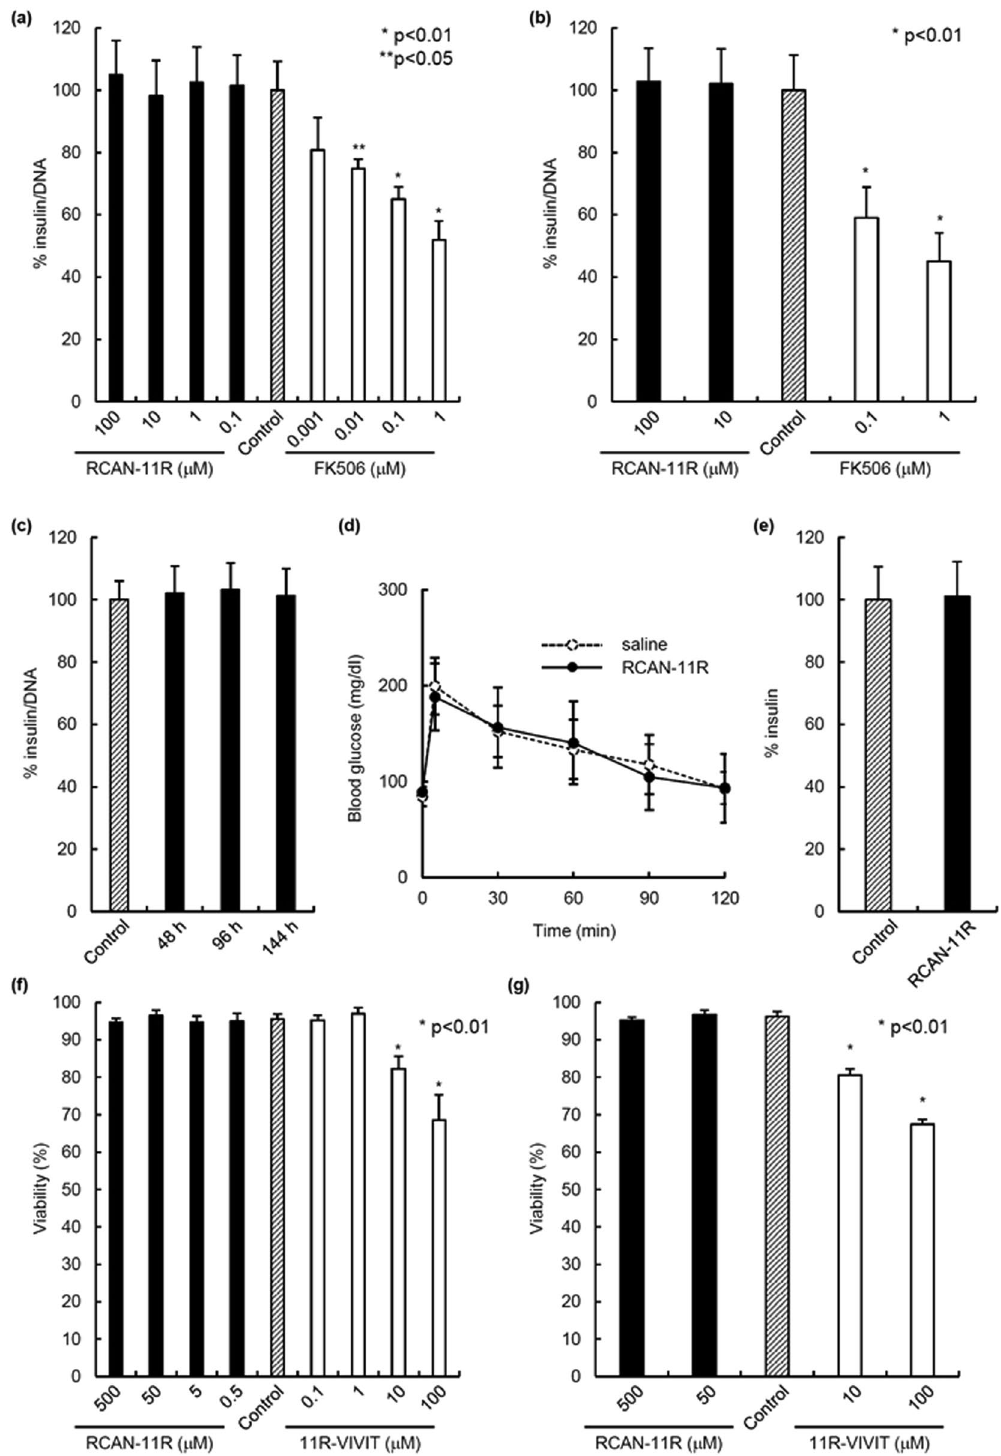
Figure 5. The effects of RCAN-11R on insulin secretion and cell viability. ( a ) Insulin secretion in β -cell line, β TC6 cells. β TC6 cells were added to 96-well plates (50,000 cells/well) with FK506 or with RCAN-11R in complete medium. The medium with FK506 or with RCAN-11R was changed every 24 hours. After 96 hours, the medium was changed and the samples for investigating the release of insulin were taken 1 hour later. The values represent the mean ± SE of five independent experiments. ( b ) Insulin secretion in isolated islets from BALB/c mice. Isolated islets from BALB/c mice were added to 24-well plates (250 IE) with FK506 or with RCAN-11R in complete medium. The medium with FK506 or with RCAN-11R was changed every 24 hours. After 96 hours, the medium was changed and the samples for investigating the release of insulin were taken 1 hour later. The values represent the mean ± SE of five independent experiments. ( c )